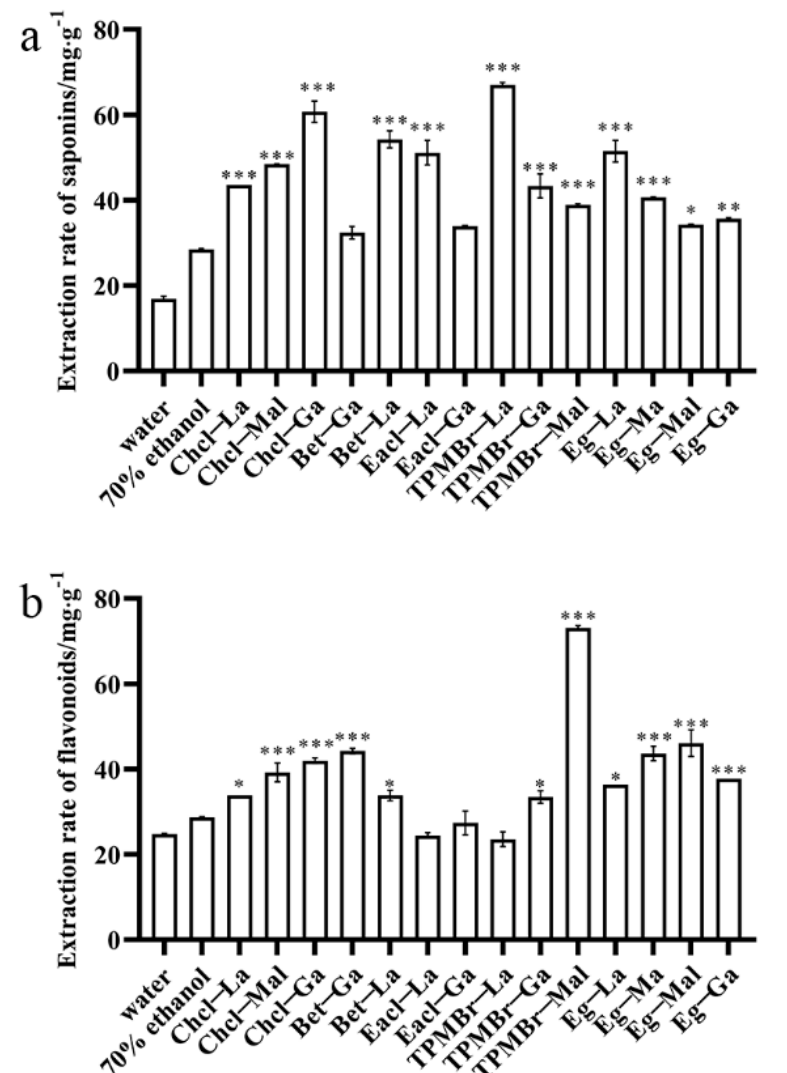
Figure 1. The extraction rate of total saponins and total flavonoids from X. sorbifolia husks using different solvents: ( a ) the extraction rate of total saponins; ( b ) the extraction rate of total flavonoids. There is a significant difference when * p < 0.05, ** p < 0.01 and *** p < 0.001 versus 70% ethanol.